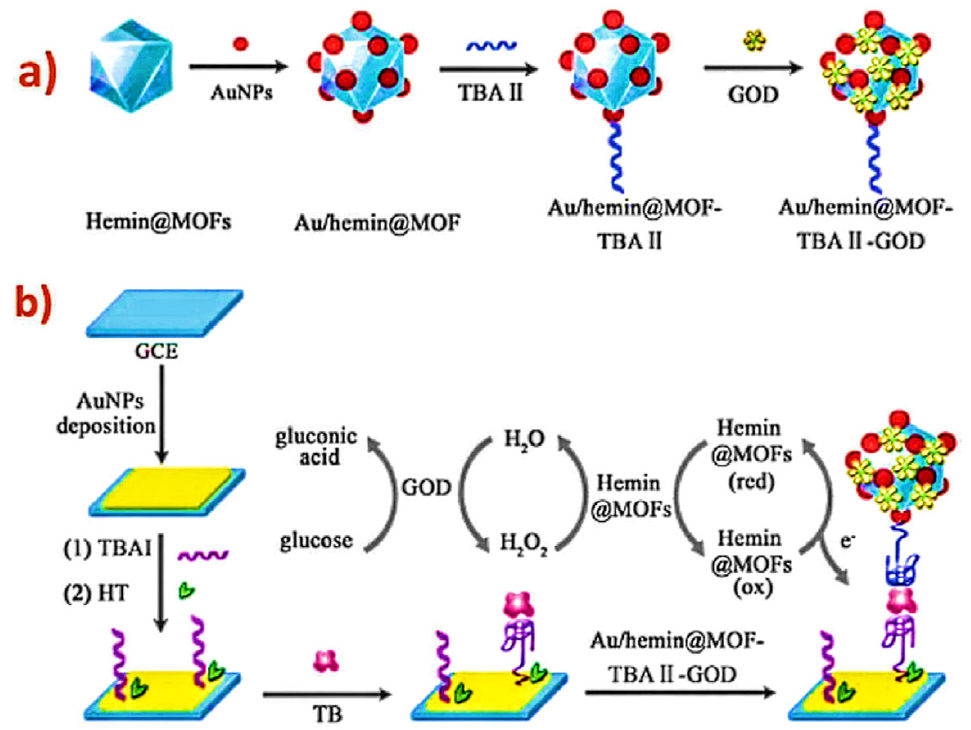
Fig. 3. Electrochemical aptasensor preparation and detection principle: (a) The preparation of Au/hemin@ MOF–TBA II–GOD preparation (b) Schematic of the stepwise assembly procedure and electrocatalytic detection principle of the proposed electrochemical aptasensor. Reproduced with permission from reference [48], copyright (2015)